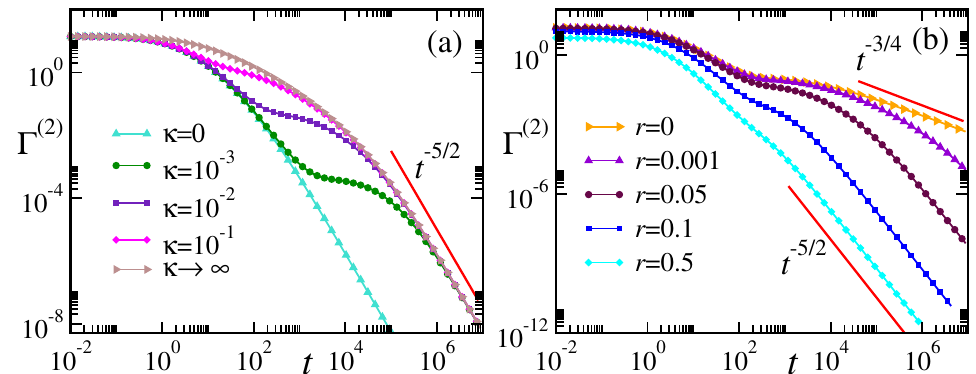
Figure 4: Effective memory kernel Γ ( 2 ) ( t ) in spatial dimension d = 3 obtained from Eqs. (69) and (46) via a numerical integration. Panel (a) shows Γ ( 2 ) ( t ) for various values of the trap stiffness κ and fixed r = 0.01 while panel (b) for various values of r and fixed κ = 0.01. The curves corresponding to the limiting cases κ → ∞ and κ = 0 reported in panel (a) are obtained from Eq. (69) by using the approximate expressions of F in, c.f., Eqs. (75) and (78), respectively. The algebraic asymptotic decays indicated in panels (a) and (b), instead, follow from Eq. (70) and Fig. 2 (see also Eq. (51)). Here we have used the interaction potential V ( z ) = e − z 2 / ( 2 R 2 ) with = D = T = R = 2, while the other parameters of the model are γ 0